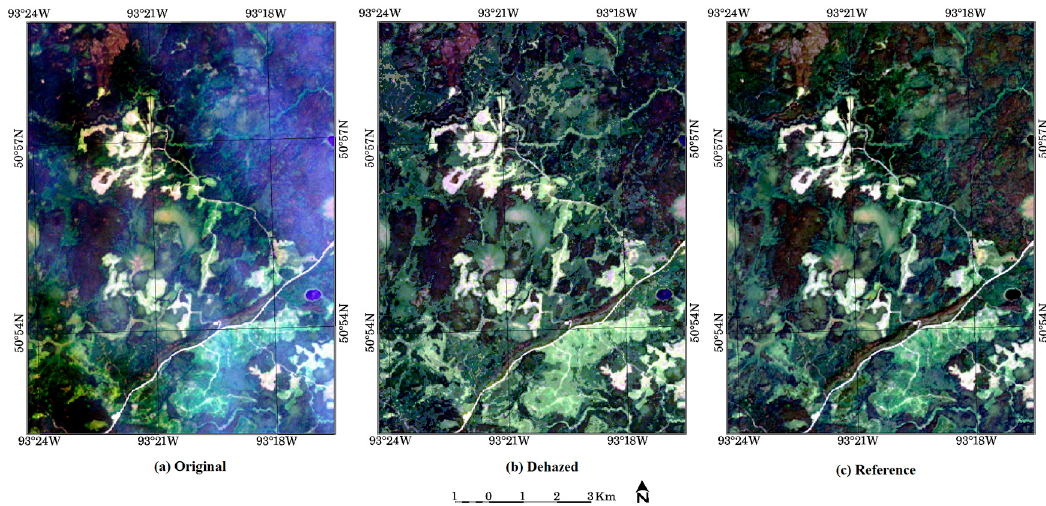
Figure 7. Comparison of hazy, dehazed (using class-based HOT radiometric adjustment (HRA)) and haze-free sub-scenes: ( a ) original hazy sub-scene acquired on 31 July 2014 (ID: LC80290242014212LGN00); ( b ) dehazed sub-scene using class-based HRA; and ( c ) haze-free reference sub-scene acquired on 16 August 2014 (ID: LC80290242014228LGN00). All images are displayed in RGB true color band combination.